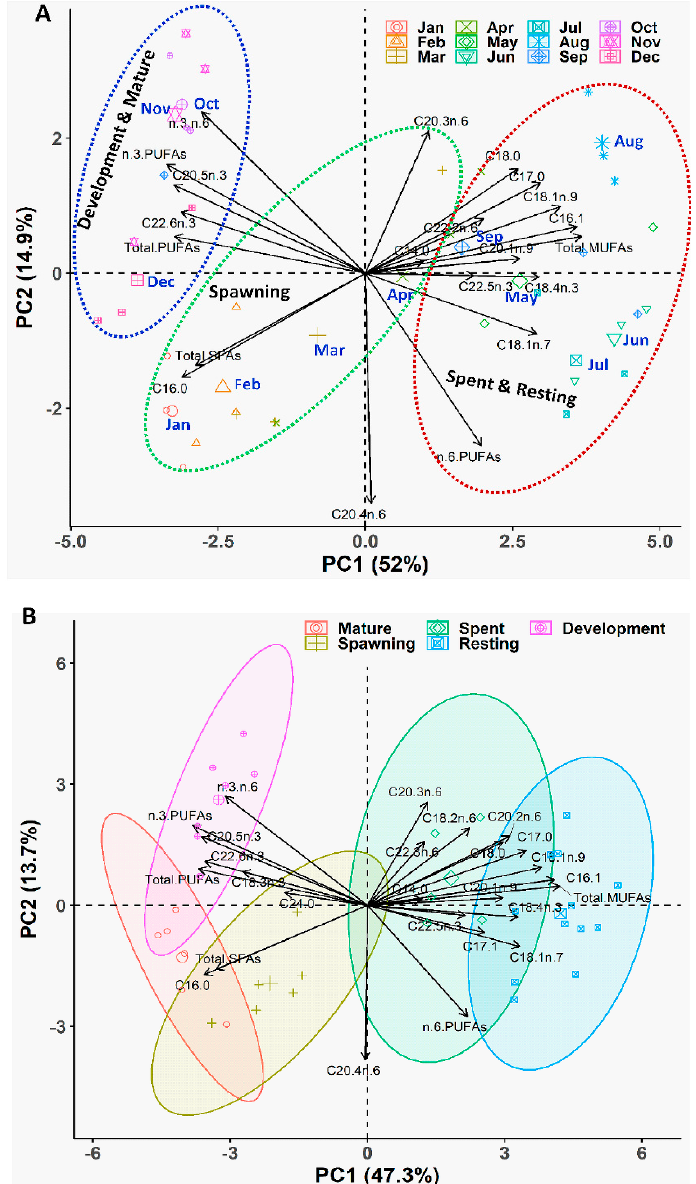
Figure 11. Biplot of principal component analysis (PCA) of the fatty acids at di ff erent months ( A ) and di ff erent gonadal stages ( B ) of green mussel Perna viridis collected from the coastal waters of Bangladesh. The PCA analysis is based on the three replicated pooled samples (each pooled sample consisted of five of the same gonadal stage green mussel) for each month (n = 36), whereas the PCA analysis of di ff erent gonadal stages consisted of six mature, six spawning, five spent, 12 resting, and seven development stage-specific pooled samples (n = 36).